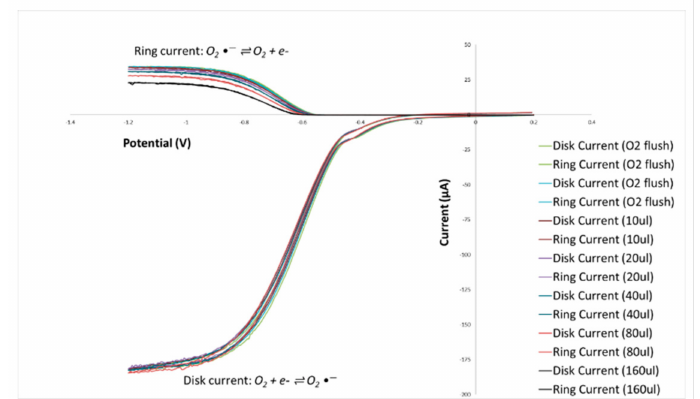
Figure 30. Effect of increasing concentrations of Butein on current-density vs. potential curves.